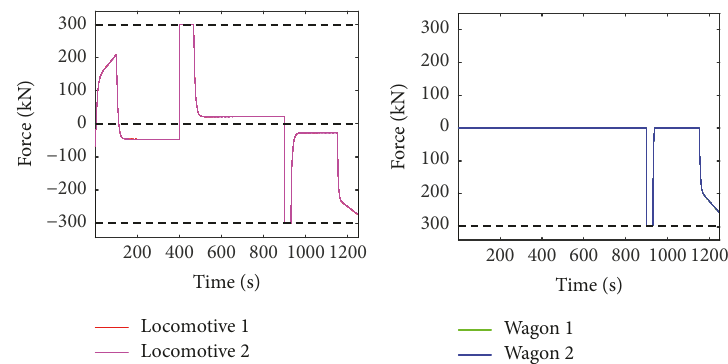
Figure 9: The forces of locomotives and wagons in Scenario B.